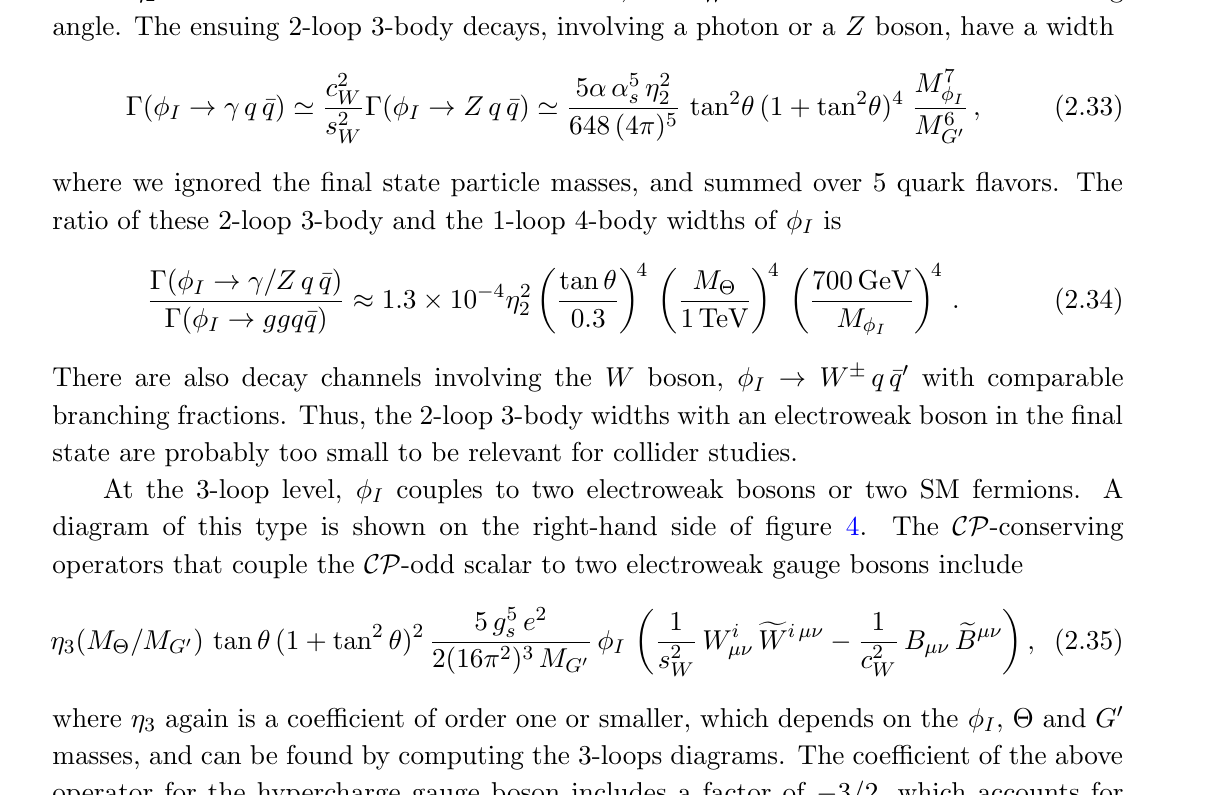
t (cid:22) th 0 at !